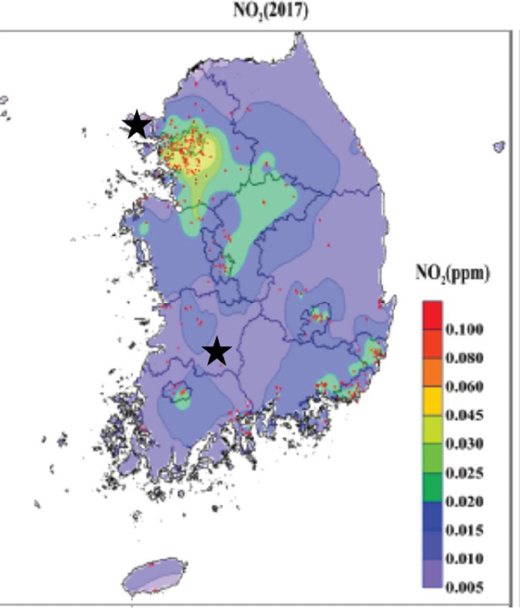
Figure 4. The contour plot of annual mean NO 2 concentrations over South Korea made only from ground measurements in 2017 (adapted from NIER, 2018). The ground measurements of ammonia at Kangwha (denoted as the northernmost black star) and at Imsil (denoted as the southernmost black star) for validating the CrIS satellite retrievals are shown.